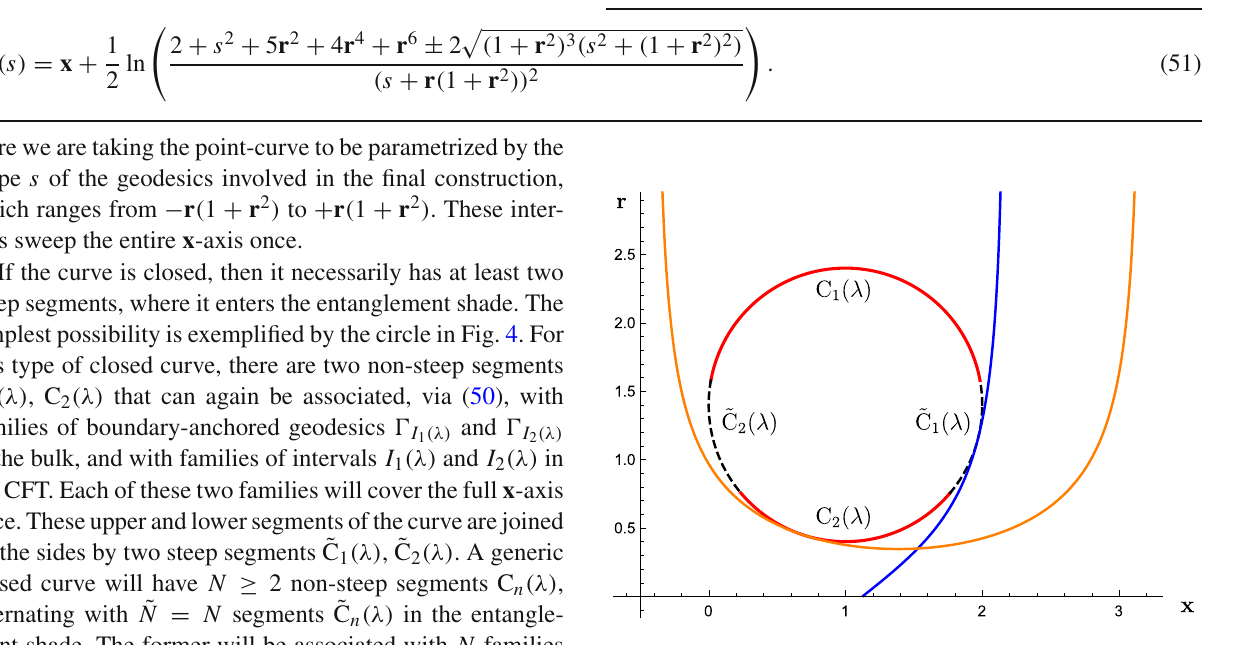
Fig. 4 Anexampleofaclosedspacelikecurve:acircleatconstanttime t , centered at x = 1, r = 1 . 4, with coordinate radius a = 1. The top and bottom, shown in solid red, have tangent geodesics of the type (8), lying fully within the Rindler wedge. A sample such geodesic is shown in orange, with both of its endpoints extending up to the boundary at r → ∞ . This is not true for the segments on the sides, shown in dashed black, which violate condition (29) and therefore cannot be reconstructedusingentanglemententropies.Geodesicstangenttothem, suchastheoneshowninblue,areofthetype(14),andhaveoneendpoint on the boundary but cross the horizon r = 0 on the other side. If we parametrize the circle by λ ∈ [ 0 , 1 ) , with λ = 0 located at the top, the gluing between the four segments occurs at the values λ = 0 . 138 , 0 . 278 , 0 . 722 , 0 . 862. If we wished, we could use null alignment (30) to reduce the size of the dashed segments, but as discussed in the main text, no choice of n can make them disappear